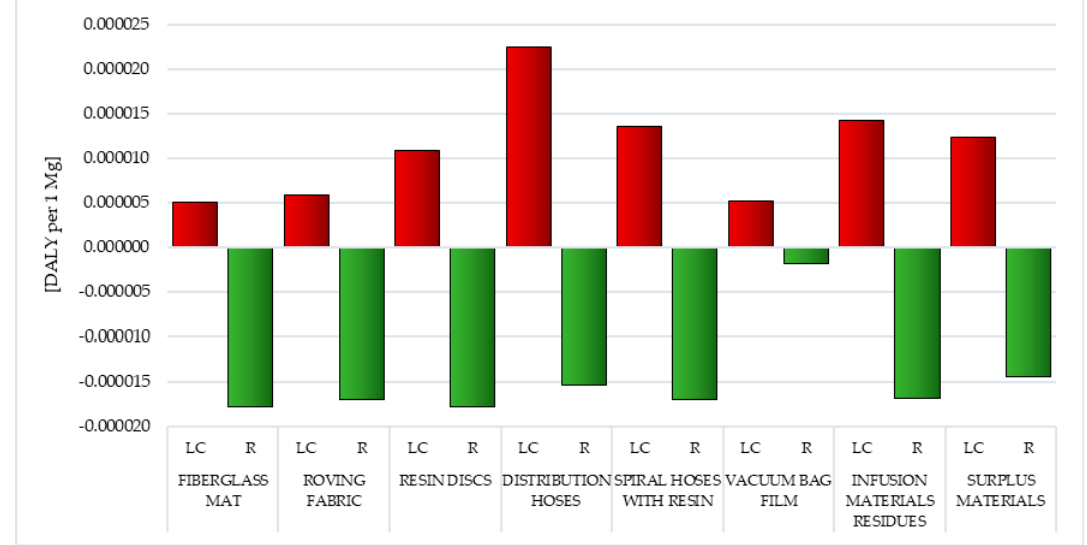
Figure 5. Characterization results of environmental consequences for organic compounds causing respiratory diseases present in selected postproduction waste of wind power plant blades: LC—life cycle, R—recycling [unit: DALY per 1 mg].